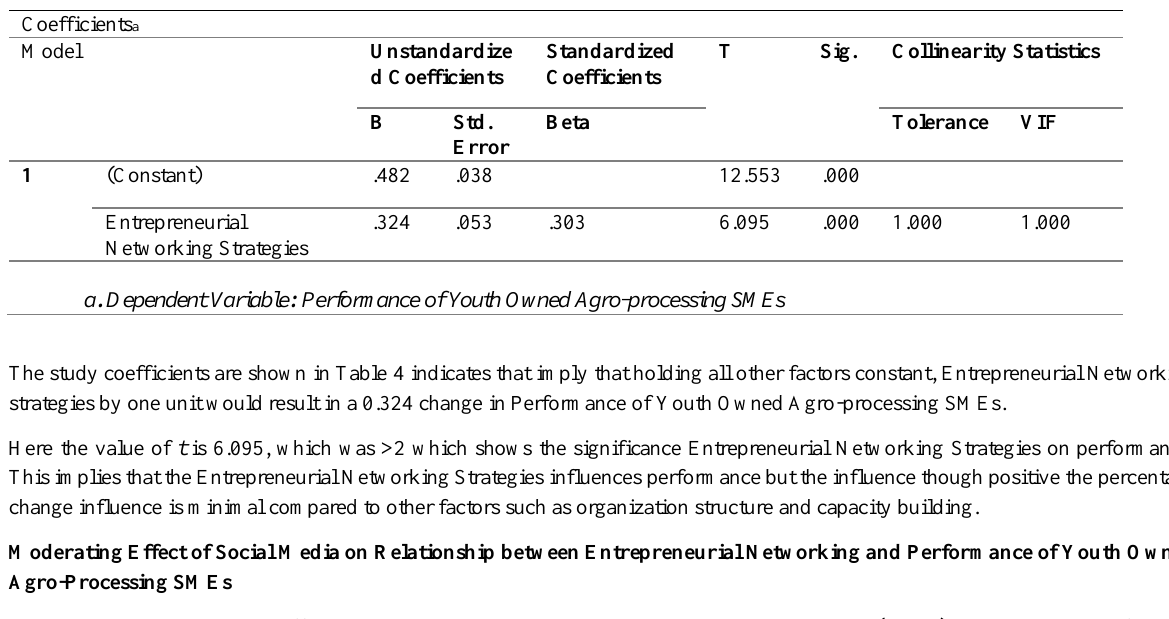
Table 4: Coefficients for Coefficients of Influence of Entrepreneurial Networking Strategies Renewal on